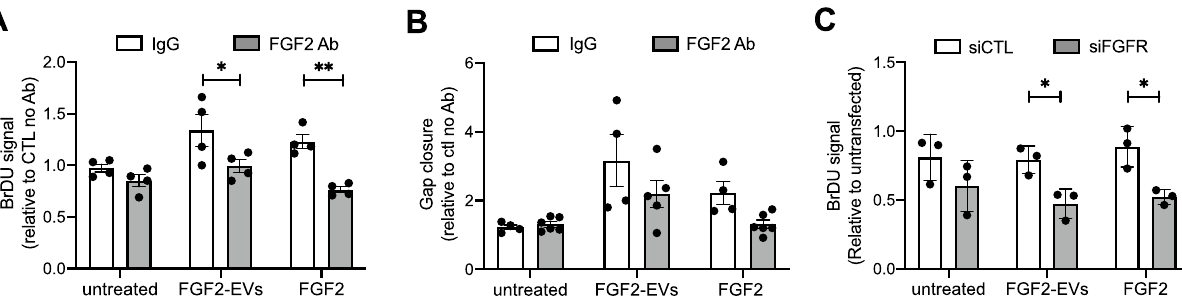
Figure 6. Effect of FGF2 inhibition on FGF2-EV activity. FGF2 effects on DF proliferation ( A , C ) and migration ( B ) were inhibited by neutralizing FGF2 antibody ( A , B ) or siRNA ( C ). FGF2-EVs were incubated with neutralizing FGF2 antibody or IgG control for 30 min prior to being added to the DF cells. The data are mean ± SE of three or four independent experiments. Statistical significance was determined by two-way ANOVA, *< 0.05, **<